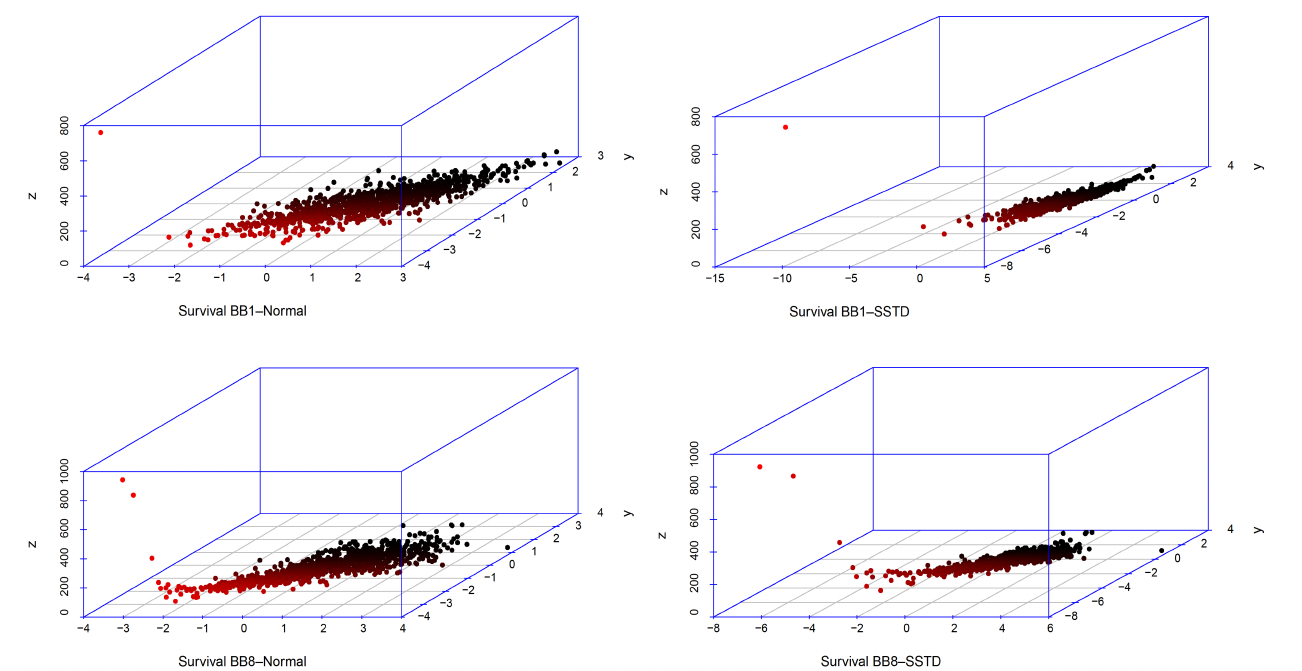
Figure 1. Three–dimensional plots based on Gaussian copula, Student- t (5) copula, survival Gumbel copula, survival BB1 copula, and survival BB8 copula under the dependence parameter, τ = 0.5, with two types of marginal distributions (Normal (0, 1) and SSTD (0.8,